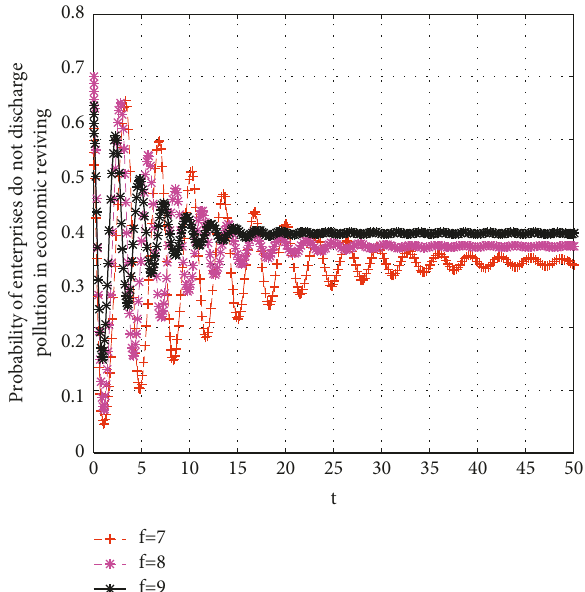
Figure 10: The evolution path of enterprises’ nondischarge with increased penalties under the dynamic incentives mechanism and penalties